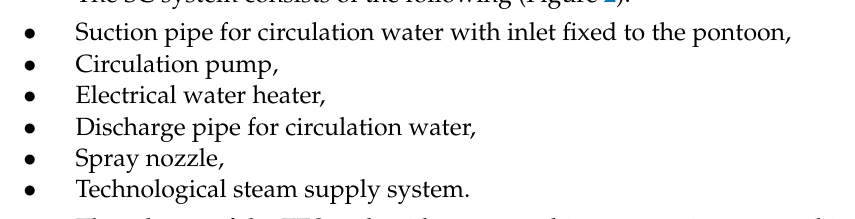
Figure 4. Main dimensions of the steam cushion systems for CHP Siekierki–Warsaw, CHP Cracow and CHP Bia ł ystok plants. A technical solution to reduce energy consumption by the SC system [27] on the ex- ample of the tank in CHP Bia ł ystok, indicating the operational parameters of the system, is shown in Figure 5.